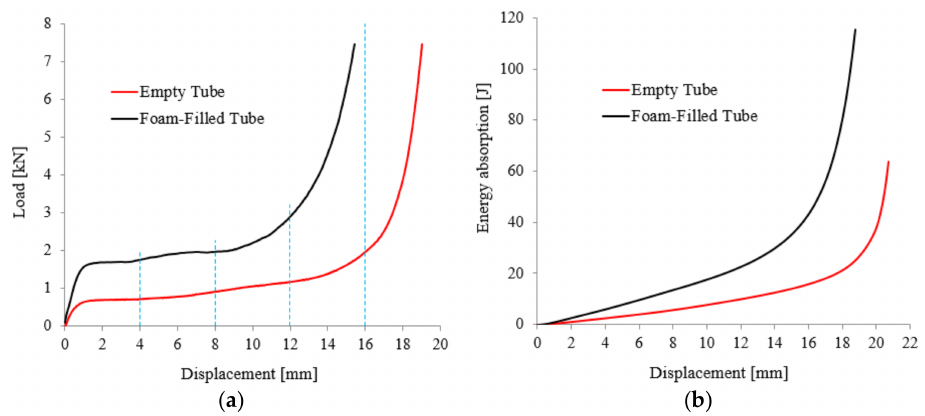
Figure 2. F- ∆ curves ( a ) and W- ∆ variation ( b ) of ETs and FFTs samples